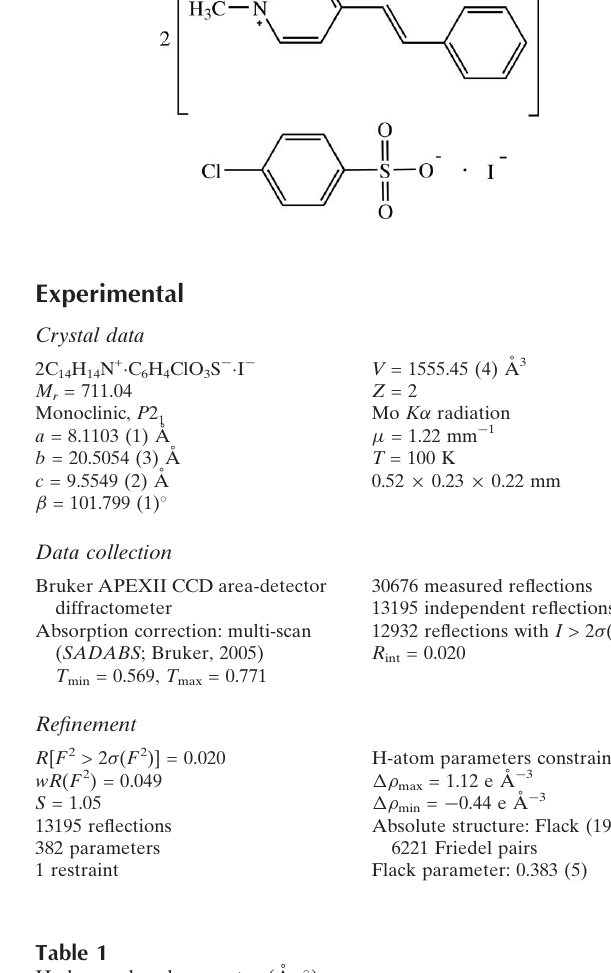
Hydrogen-bond geometry (A˚ , (cid:4)